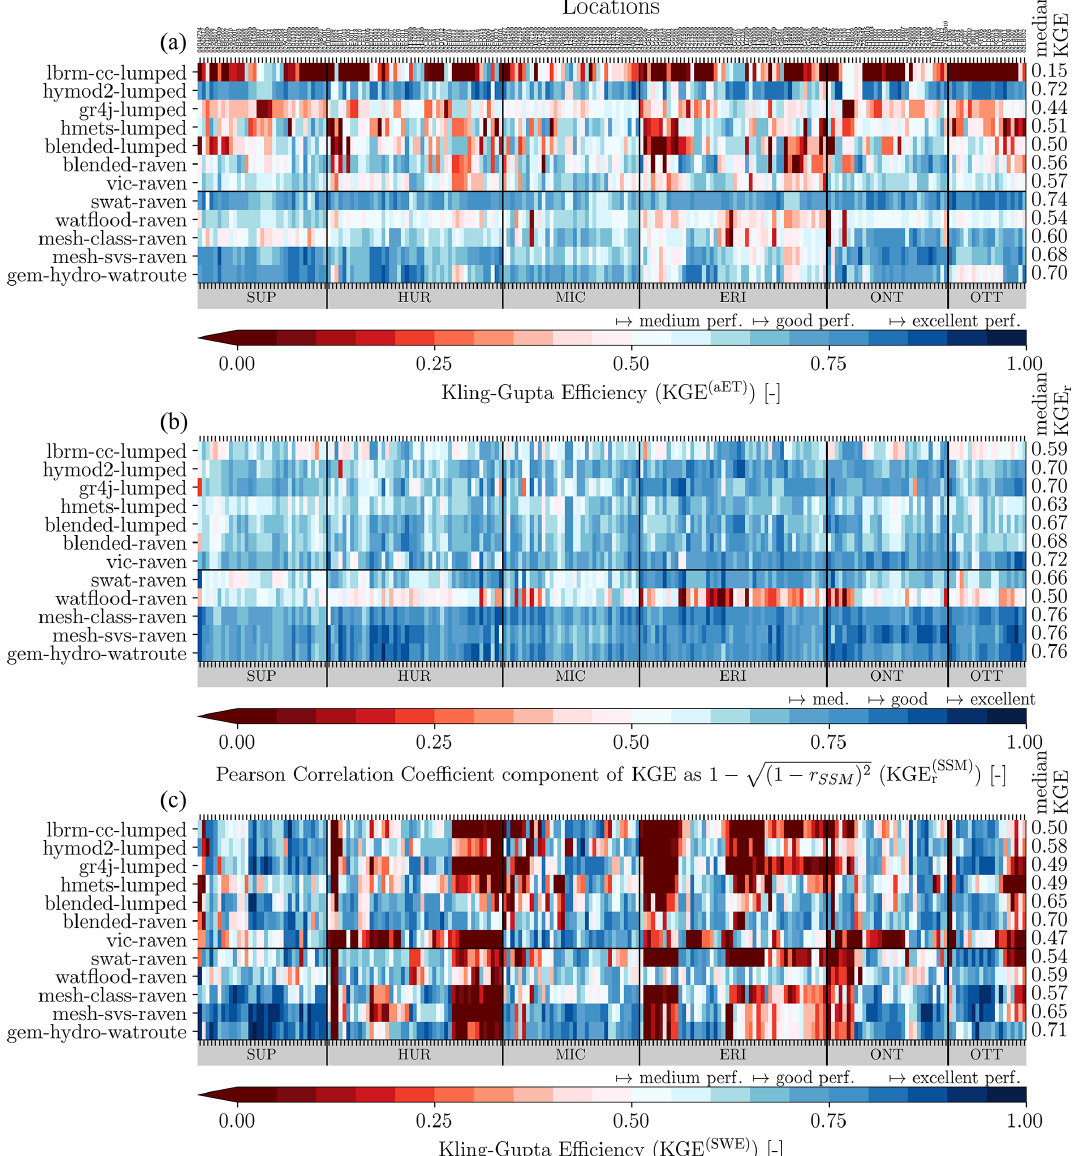
Figure 4. Basin-wise model performance regarding auxiliary variables. The performance of 12 models ( y axis) is shown for (a) actual evapotranspiration, (b) surface soil moisture, and (c) snow water equivalent. The model outputs are aggregated to the 212 basins ( x axis) used in this study (141 calibration locations and 71 validation locations). The performance is evaluated for observations available between 2001 and 2017 (the overall period used for streamflow calibration and validation). The Kling–Gupta efficiency (KGE) is used to evaluate the simulations of actual evapotranspiration and snow water equivalent, while the Pearson correlation is used for the (standardized) surface soil moisture. The color bar in each panel is organized such that blue (red) colors indicate good (poor) performance. The machine-learning- based LSTM model is not simulating these additional variables and is hence not included. The basins ( x axis) are grouped into six regions of the Lake Erie (ERI), Lake Huron (HUR), Lake Michigan (MIC), Lake Ontario (ONT), Ottawa River (OTT), and Lake Superior (SUP) watersheds. The basin order is the same across the three panels. The horizontal black line separates models that are calibrated locally from models that are calibrated per region. For the spatial distribution of these results and the simulated and reference time series, please refer to the website (e.g., the website for actual evapotranspiration; http://www.hydrohub.org/grip-gl/maps_aet.html, last access: 6 July 2022).